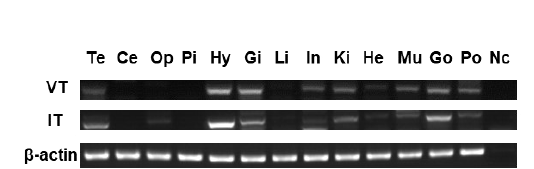
male seahorses by reverse transcription PCR. The brain regions: Te, telencephalon; Ce, cerebellum; Op, optic tectum; Pi, pituitary; and Hy, hypothalamus. The peripheral tissues: Gi, gill; Li, liver; In, intestine; Ki, kidney; He, heart; Mu, muscle; Go, gonad; Po, brood pouch. Nc, negative control.